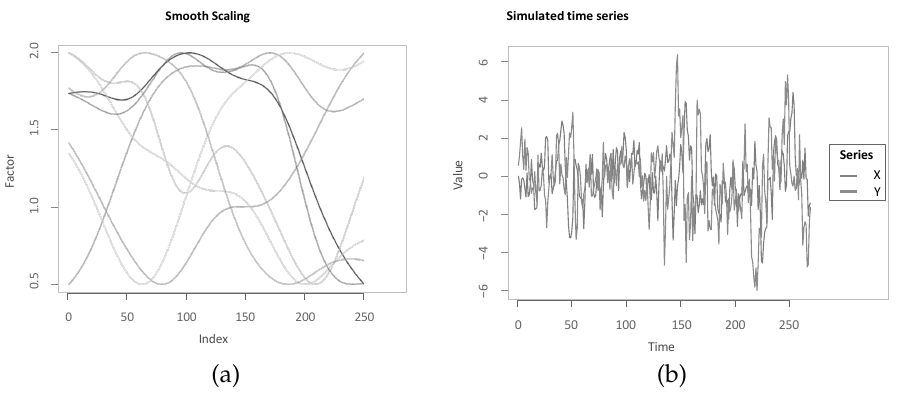
Figure 14. Robustness check towards smooth scaling. ( a ) smooth scaling series; ( b ) simulated time series with smooth scaling.